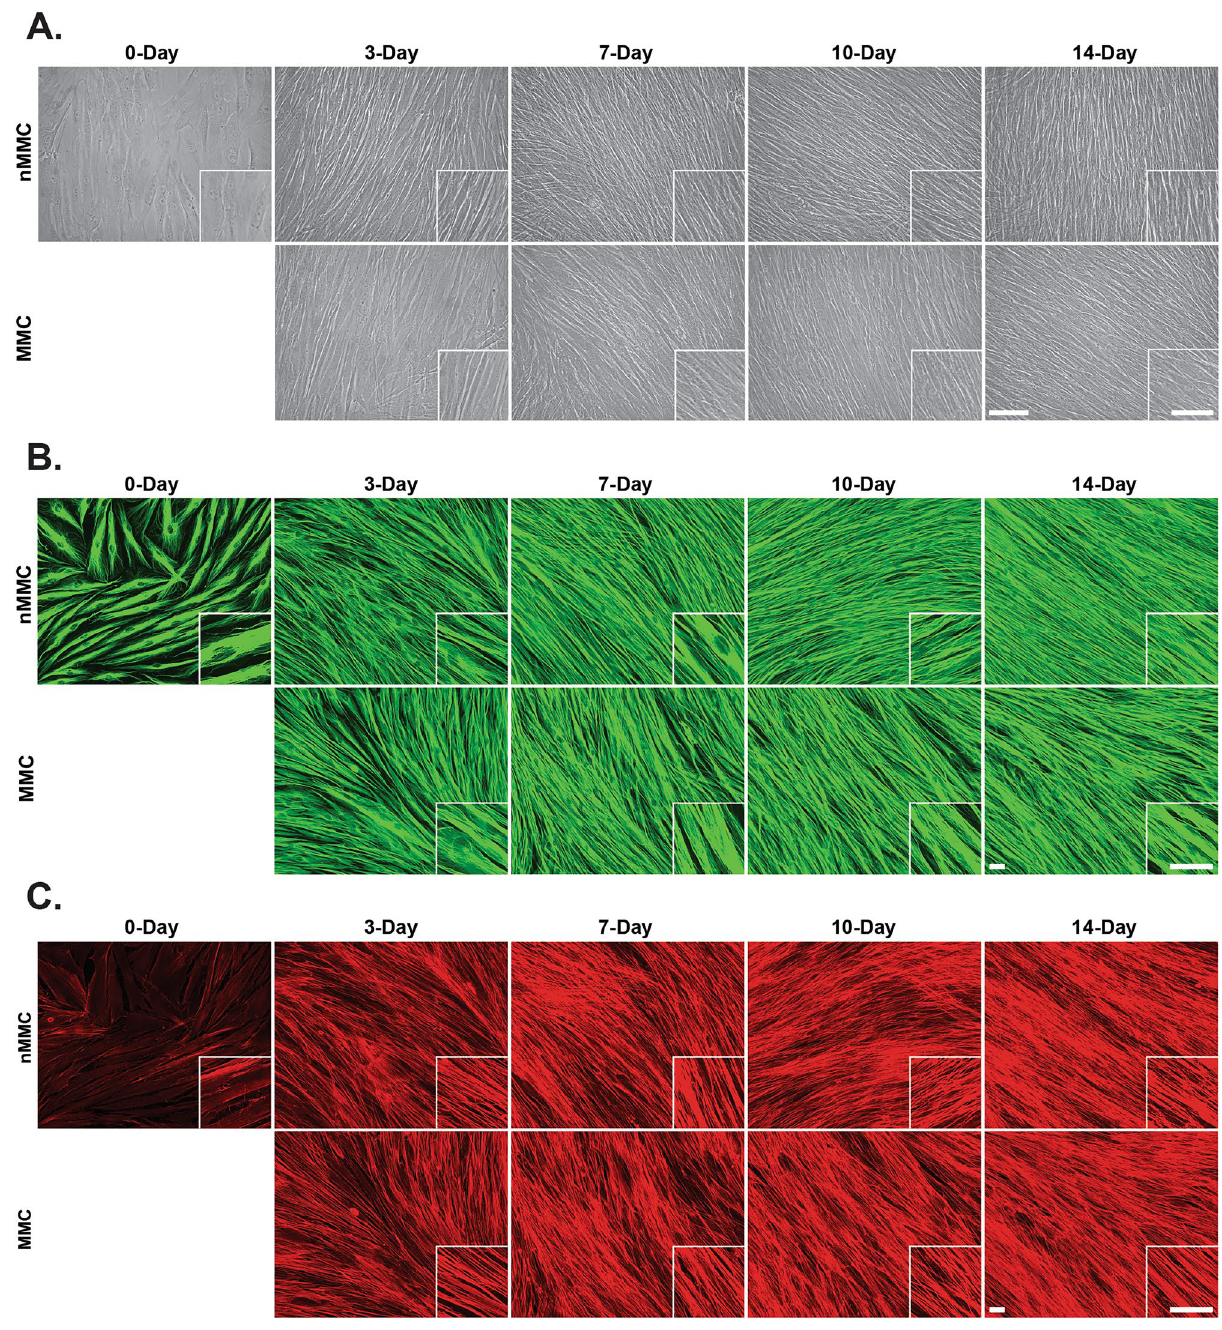
Figure 1. Characterization of fibroblast MMC and nMMC cultures by phase contrast microscopy and immunostaining of cytoskeletal β-tubulin and actin over time. Representative phase contrast microscope ( A ), immunostaining of β-tubulin ( B ), and staining of total fibrillar actin with fluorescently labelled phalloidin ( C ) images from 6 to 12 standardized images obtained from each time point and treatment from two repeated experiments are shown. Inserts show higher magnification of select areas. Images in inserts are individually optimized for brightness/contrast. Magnification bars = 40